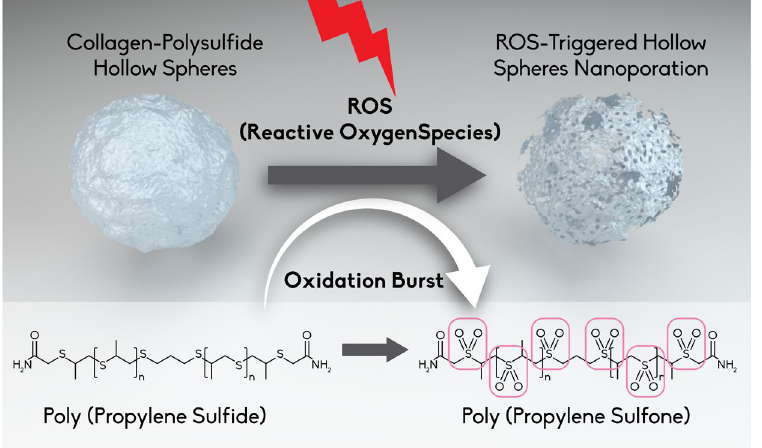
Figure 9. Schematic representation of the nanoporation which the collagen-PPS hollow spheres undergo a in the presence of ROS due to the oxidation-triggered swelling switch of poly(propylene sulfoxide) to poly(propylene